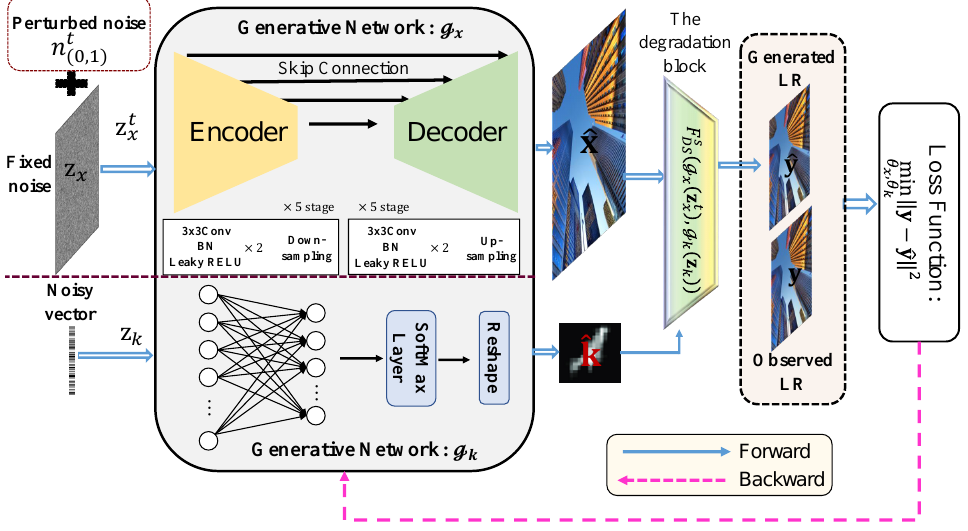
Figure 1. The schematic concept of the proposed zero-shot blind SR learning framework (ZSB-SR). Contrary to the image prior learning subnet G x with the encoder–decoder architecture for capturing the low-level statistics of natural images, we adopted a simpler network to model the prior of the blurring kernel since k has a much lower dimensionality and simplex spatial structure. Specifically, we employed a fully connected network (FCN) to serve as G x and used a one-dimensional noise vector z k as the input data. The overall structure of G k is shown in the gray background window of Figure 2, which is composed of a hidden layer, an output layer with m 2 nodes, and a SoftMax layer to constrain the non-negativity and equality of the learned element in k . Finally, the 1D output with the m 2 entries is reshaped into the 2D m × m matrix as the predicted blurring